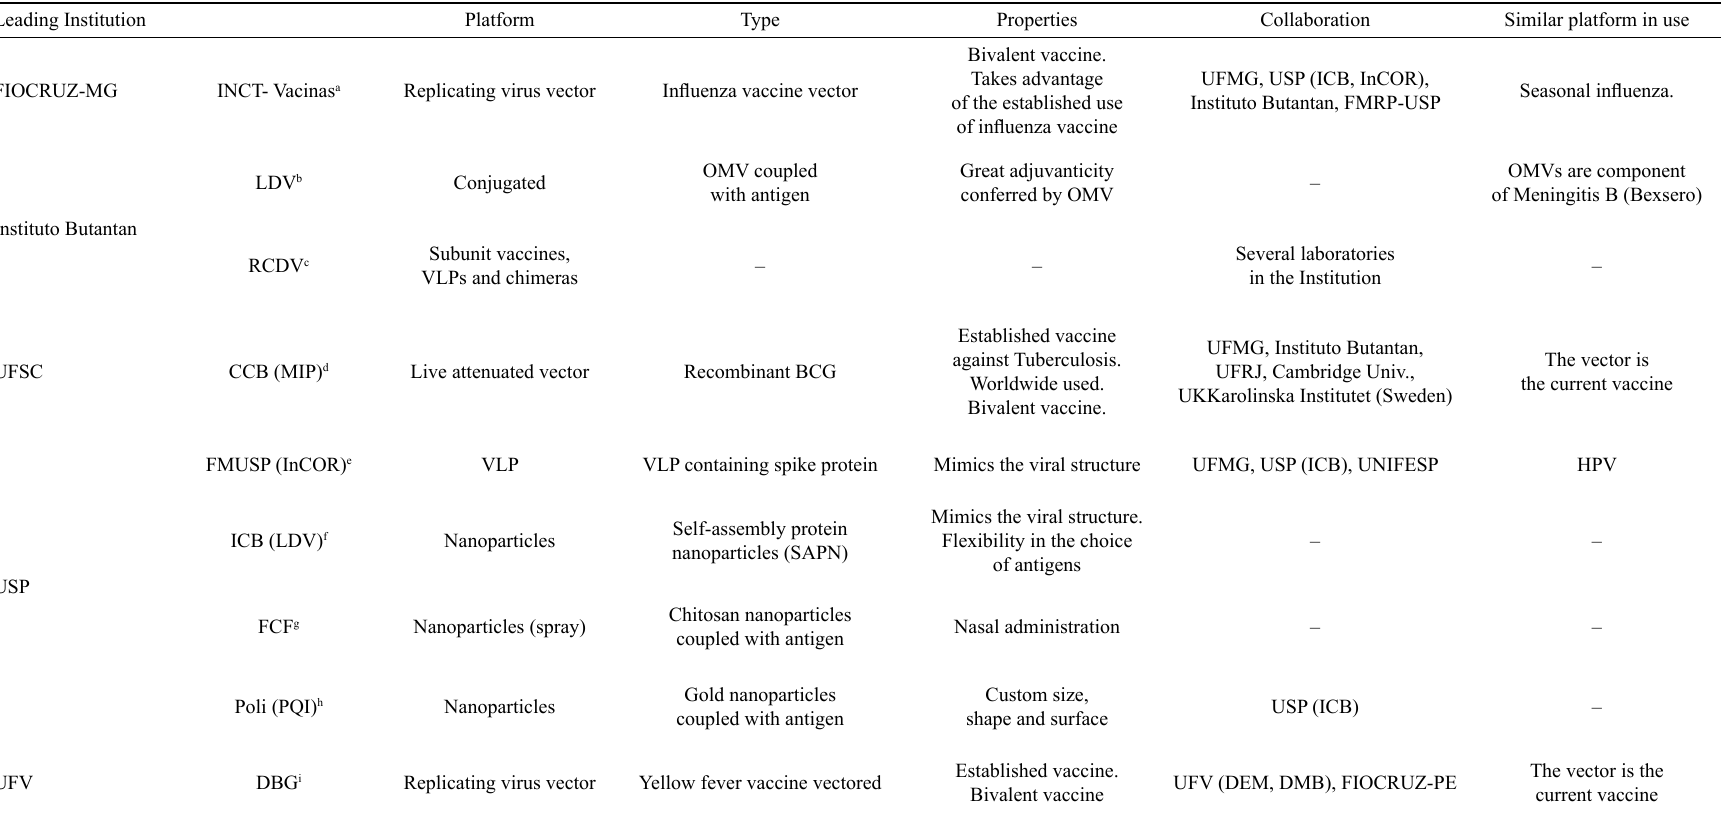
Table 2 – Brazilian initiatives on vaccine development for